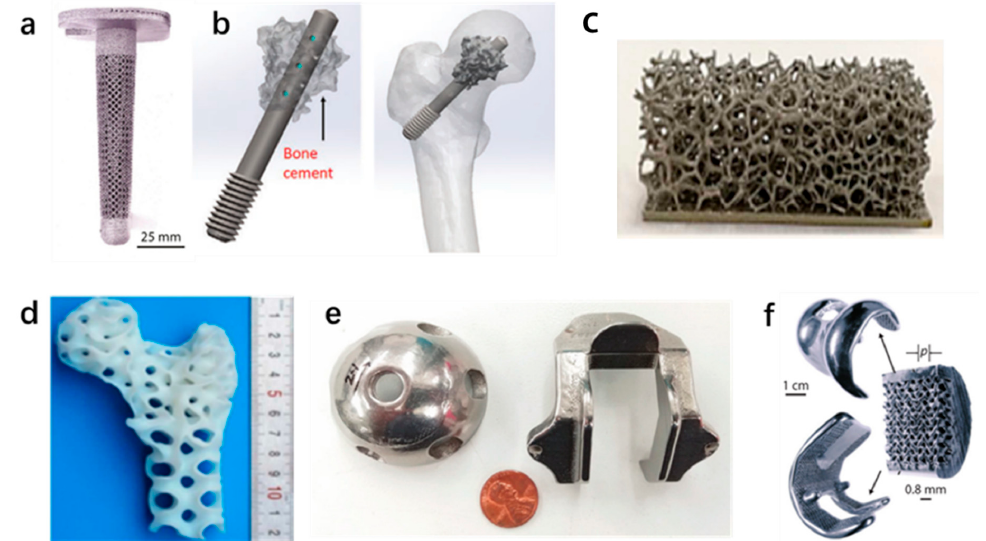
Figure 4. Examples of the application of various metals in biological tissue engineering: ( a ) Ti-64 tibial shaft structure [94]; ( b ) magnesium-based screw with holes in the shaft for injection of bone cement to repair femoral head necrosis [48]; ( c ) Magnesium porous bone scaffold [72]; ( d ) magnesium bone implants using laser additive manufacturing [72]; ( e ) 316 L stainless steel manufactured by PBF process [95]; ( f ) Co–Cr knee implant [94].